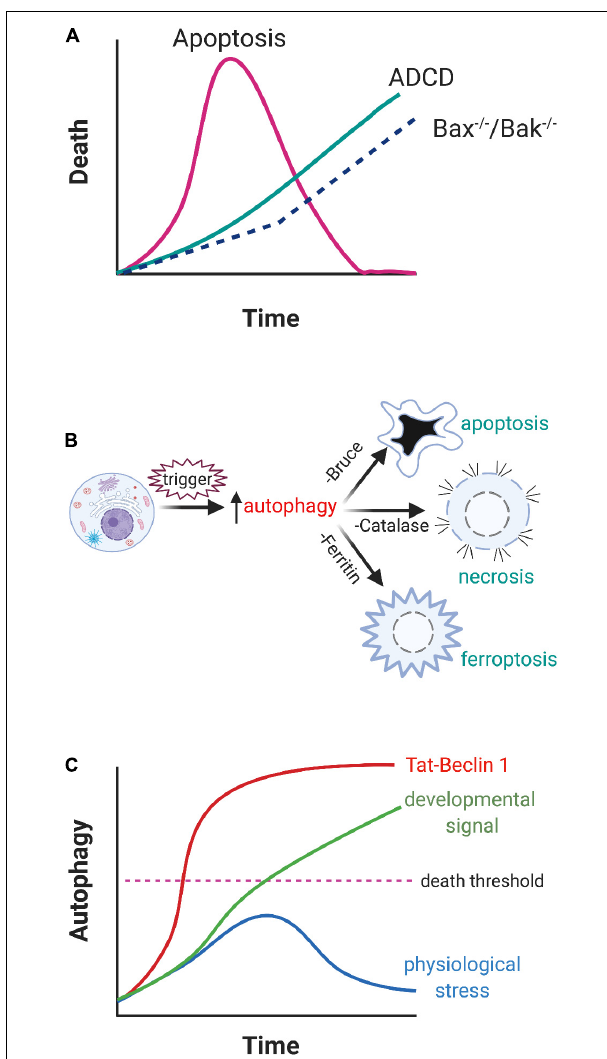
FIGURE 2 | Proposed ADCD pathways. (A) Both apoptosis and ADCD are triggered concurrently but the speed of apoptosis masks the involvement of ADCD. Blockage of apoptosis in Bax - / - Bak - / - cells allows autophagy to progress to the death of the cell. (B) Autophagy derepresses other cell death programs. By selectively targeting key survival proteins, compromised cells are able to activate non-autophagic cell death programs. (C) Treating cells with potent autophagy inducers like Tat-Beclin 1 results in the rapid demise of the cells (above the dashed “death threshold” line). If a cell is subjected to mild stresses, it transiently upregulates autophagy, which helps it survive the insult. However, when the cell is exposed to a cell death inducer during development, autophagy is driven past the point of no return and the cell dies.